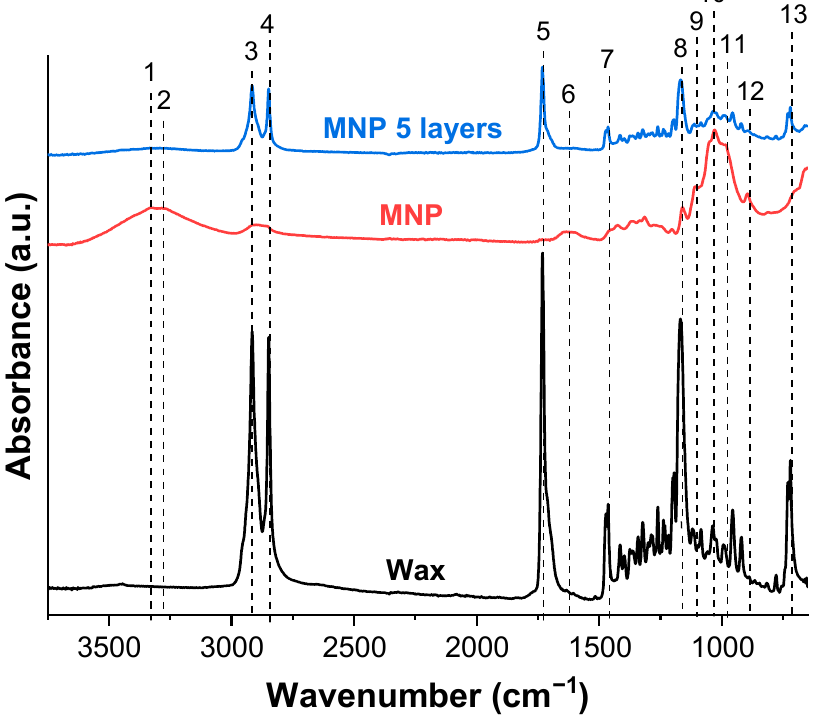
Figure 8. FTIR of pine wax, MNP, and five-layer dip-coated MNP with 1.0 wt.% wax solution (1–13 explained in Table 1). Table 1. Assignments of the infrared absorption bands.